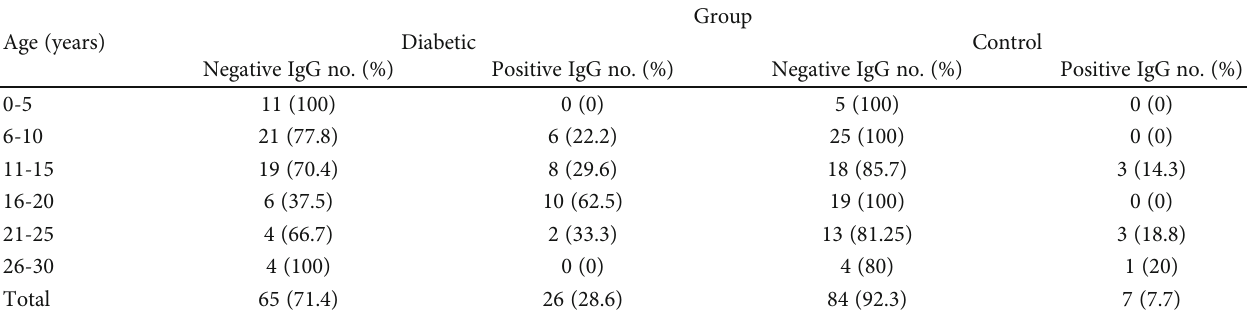
Table 7: Anti- Toxoplasma IgG and age group distribution in both